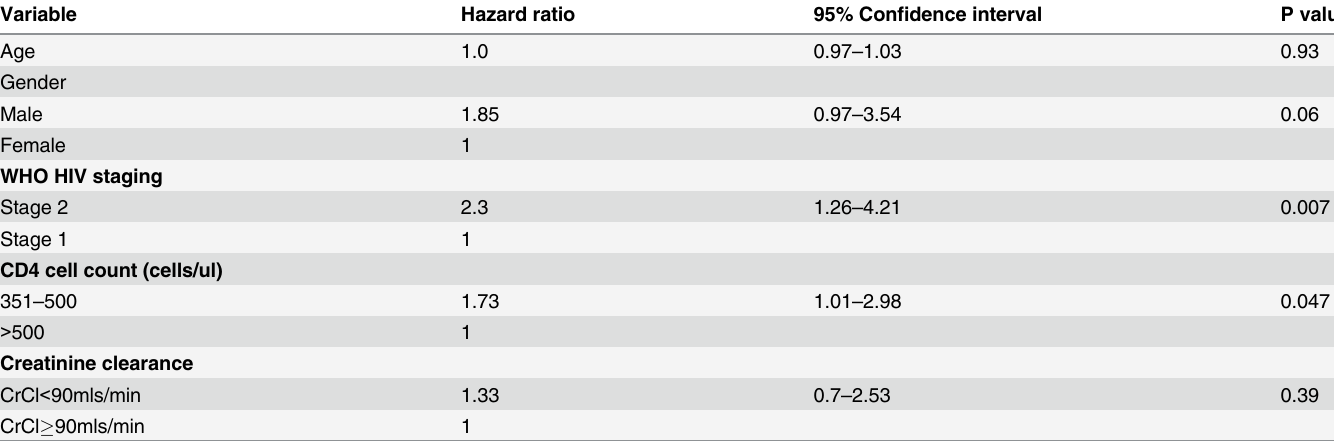
Table 3. Predictors of time to ART initiation as determined by Cox proportional regression analysis.